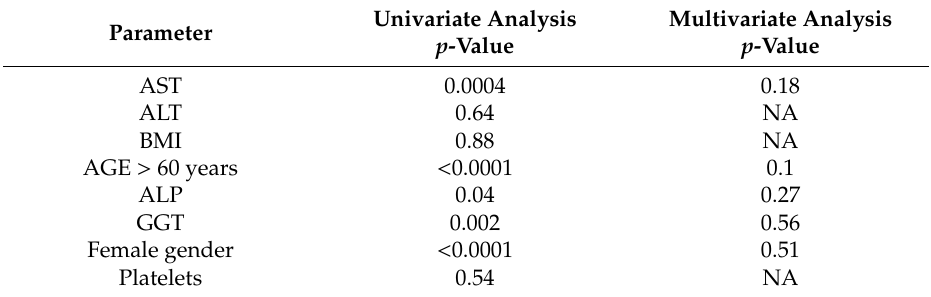
Table 4. Univariate and multivariate analysis of factors associated with the THE